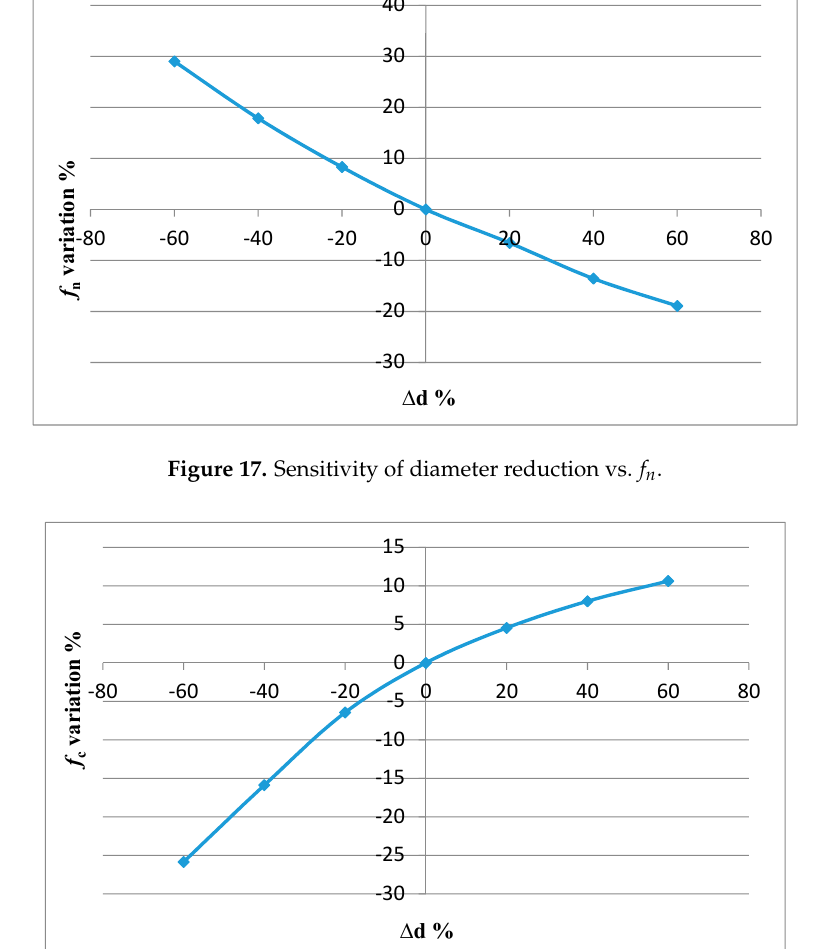
Figure 18. Sensitivity of diameter reduction vs. f c . Appl. Sci. 2017 , 7 , x